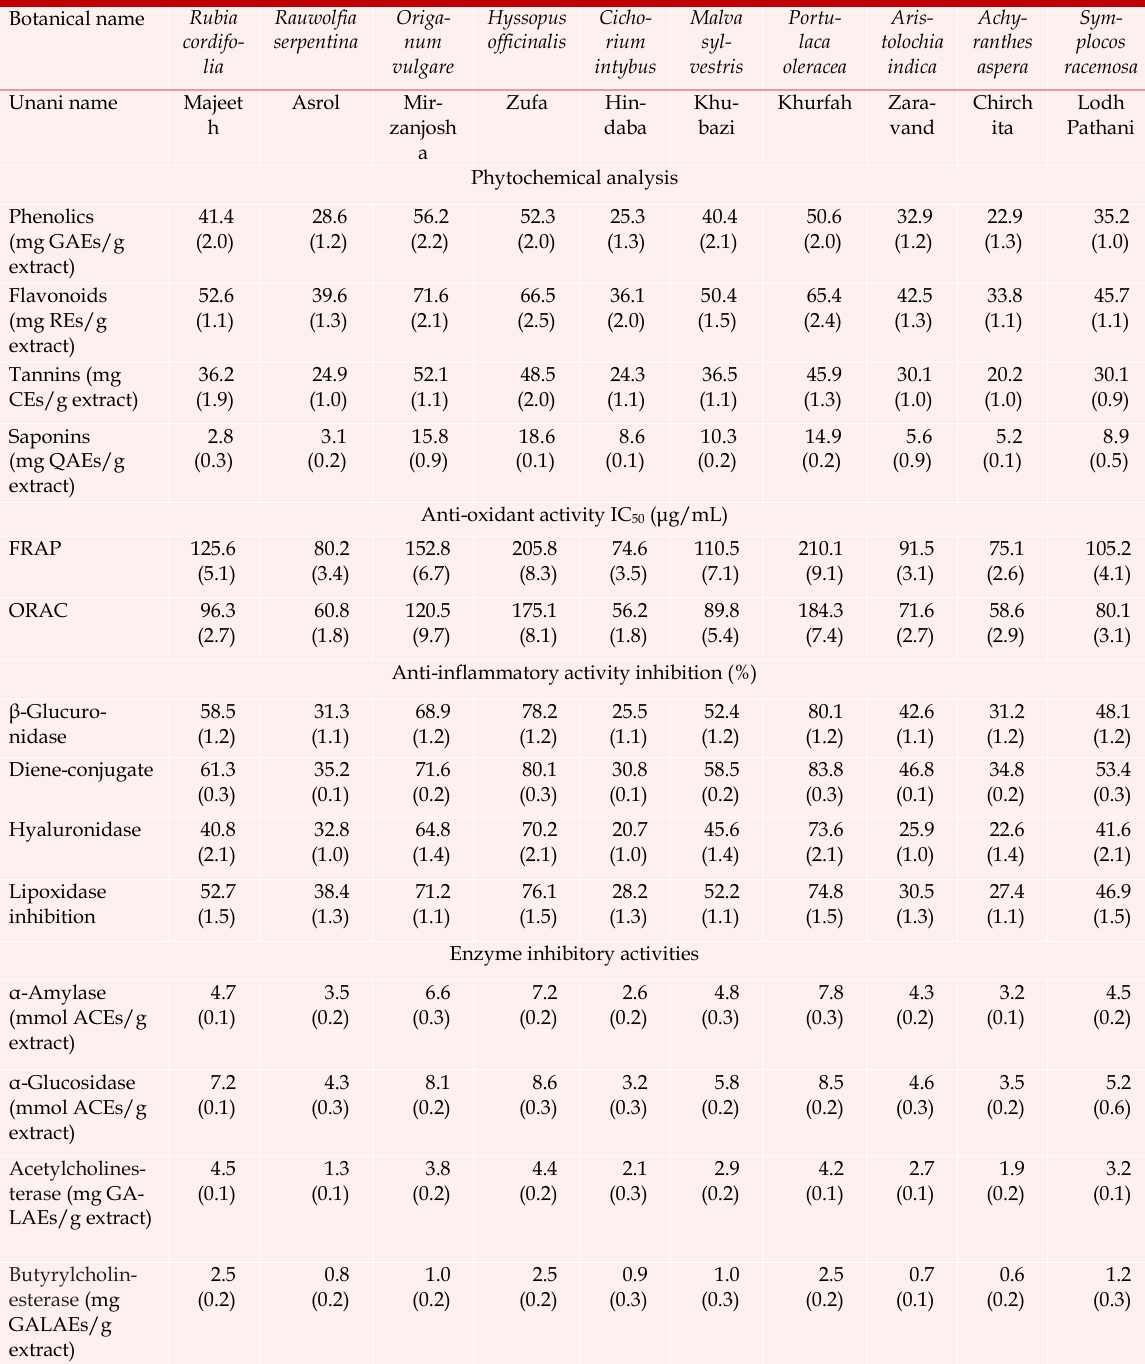
Phytochemical analysis, anti-oxidant and enzyme inhibitory activities of the extracts of selected herbs